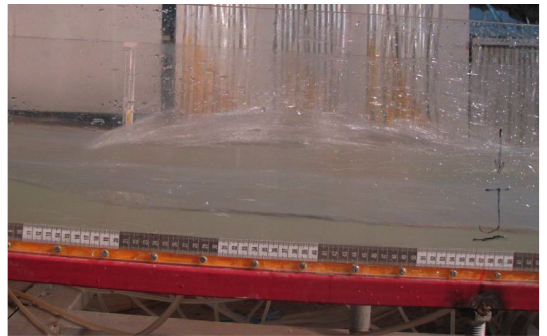
Figure 19: Separation of wave 2 from the main core of water